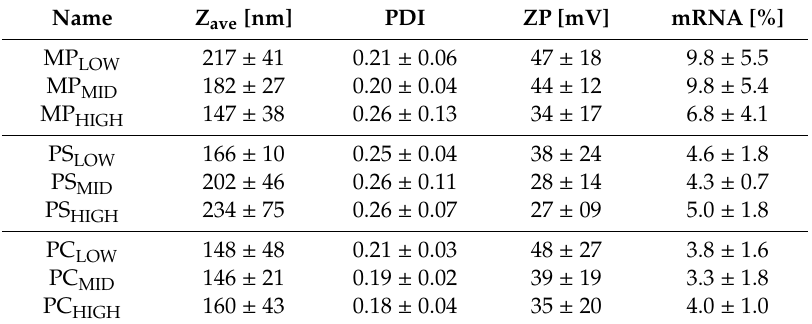
Table 1. Physicochemical characterization of the final particles from the three di ff erent assembly sequences (MP, PS, PC), each with three di ff erent protamine contributions to the N / P ratio composition (LOW, MID,